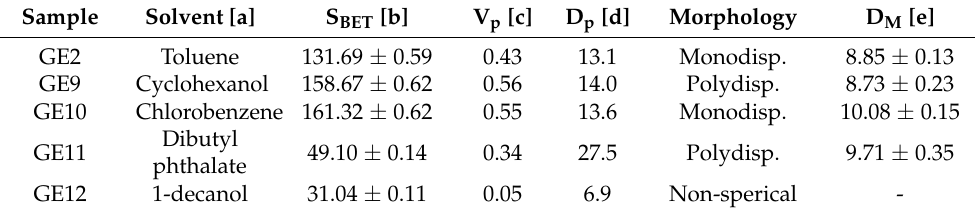
Table 4. Effect of porogenic solvent type on morphology and porous